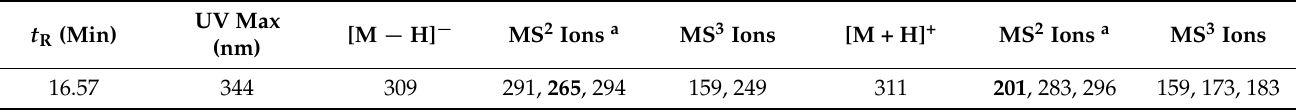
Table 1. Tandem mass spectrometry analysis of arachidin-6 detected in ethyl acetate extract from the medium of elicited peanut cv. Tifrunner hairy root culture. Analysis was done by HPLC-PDA-electronspray ionization-MS 3 . t R